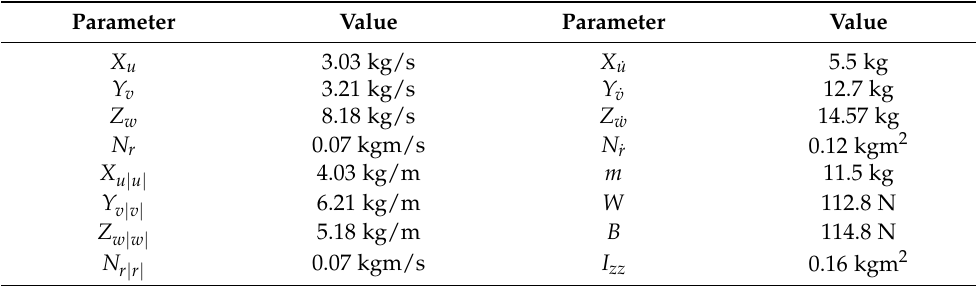
Table 1. Underwater vehicle parameters used in